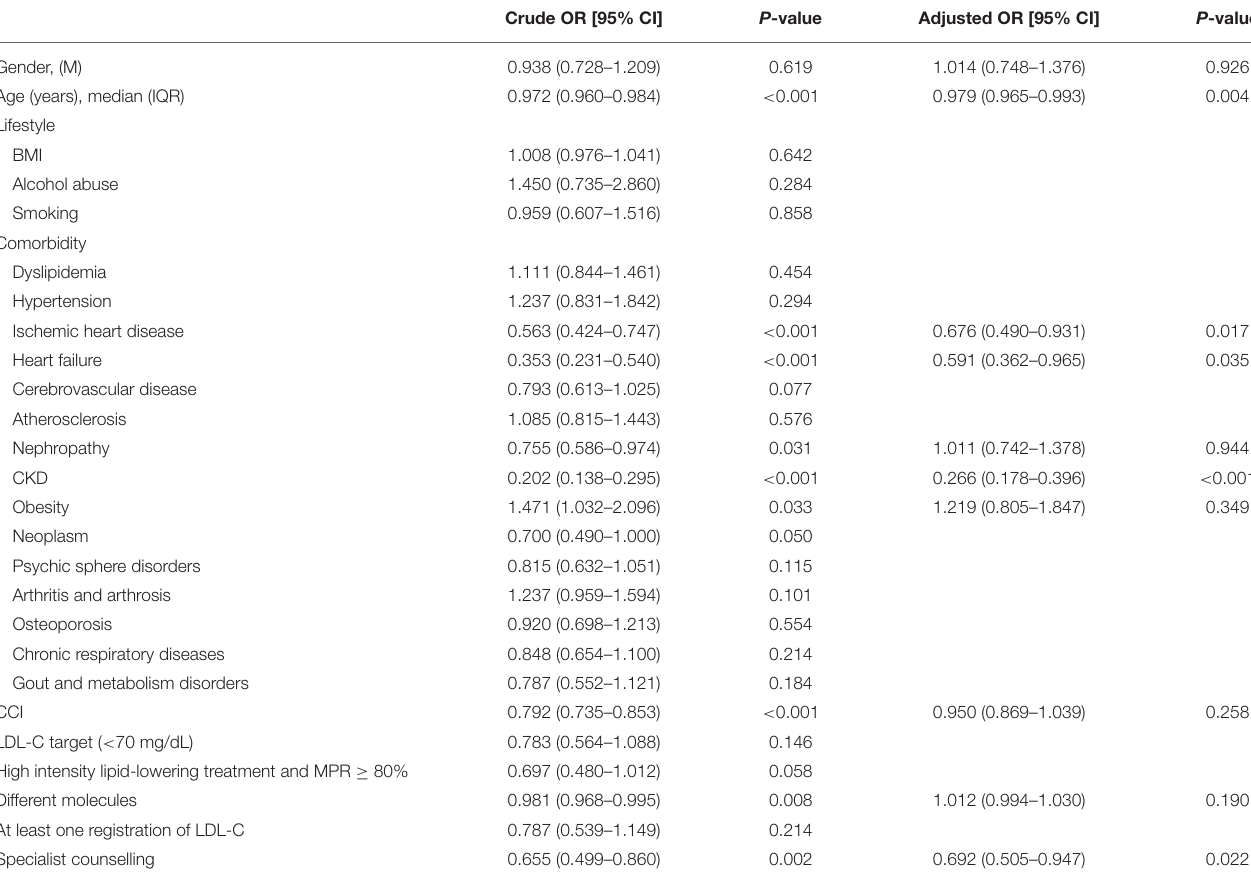
TABLE 4 | Predictors of the inappropriateness of hypoglycemic